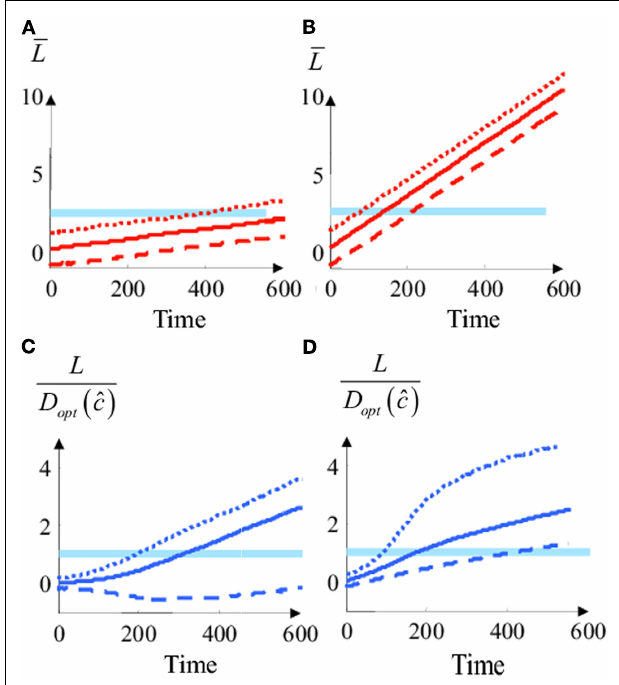
FIGURE 5 | Simplified Bayesian model and “diffusion” model with changing priors. (A) Average integrated input divided by the threshold ( ¯ L / D ) as a function of time in the diffusion model at low coherence t ( c = 0.2). Plain Lines: the two choices are a priori equiprobable ( L o = 0). Dashed line: B is a priori more probable than A ( L o =− 0.6). Dotted line: A is a priori more probable than B ( L o = 0.6). In the diffusion model, the prior is implemented by a constant offset of the decision variable, i.e., a different starting point for integration. (B) The same as in (A) for medium motion coherence ( c = 1). (C) Log odds divided by the decision threshold [i.e., L / D opt ( ˆ c )] for the simplified Bayesian decision model at low coherence ( c = 0.2). Dashed, dotted and plain lines correspond to different priors [same as in (A) ] (D) . Same as (C) but for a high value of motion coherence ( c = 2).